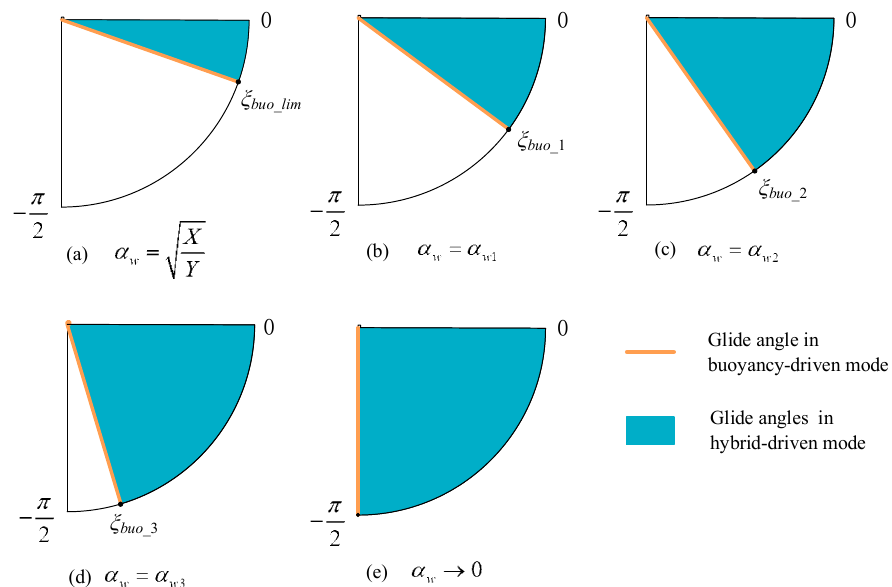
Figure 6. The glide angle ranges with different wing installation angles in two driving modes. ( a ) (cid:113) X When a w = , the corresponding glide angle in buoyancy-driven mode is the limit glide angle Y ξ buo _ lim , ( b – d ) When the wing installation angles of the glider are a w 1 , a w 2 , and a w 3 , the corresponding glide angle in buoyancy-driven mode are ξ buo _1 , ξ buo _2 , and ξ buo _3 , respectively and ( e ) When the wing installation angle approaches zero, the corresponding glide angle in buoyancy-driven mode is approaches − π . 2